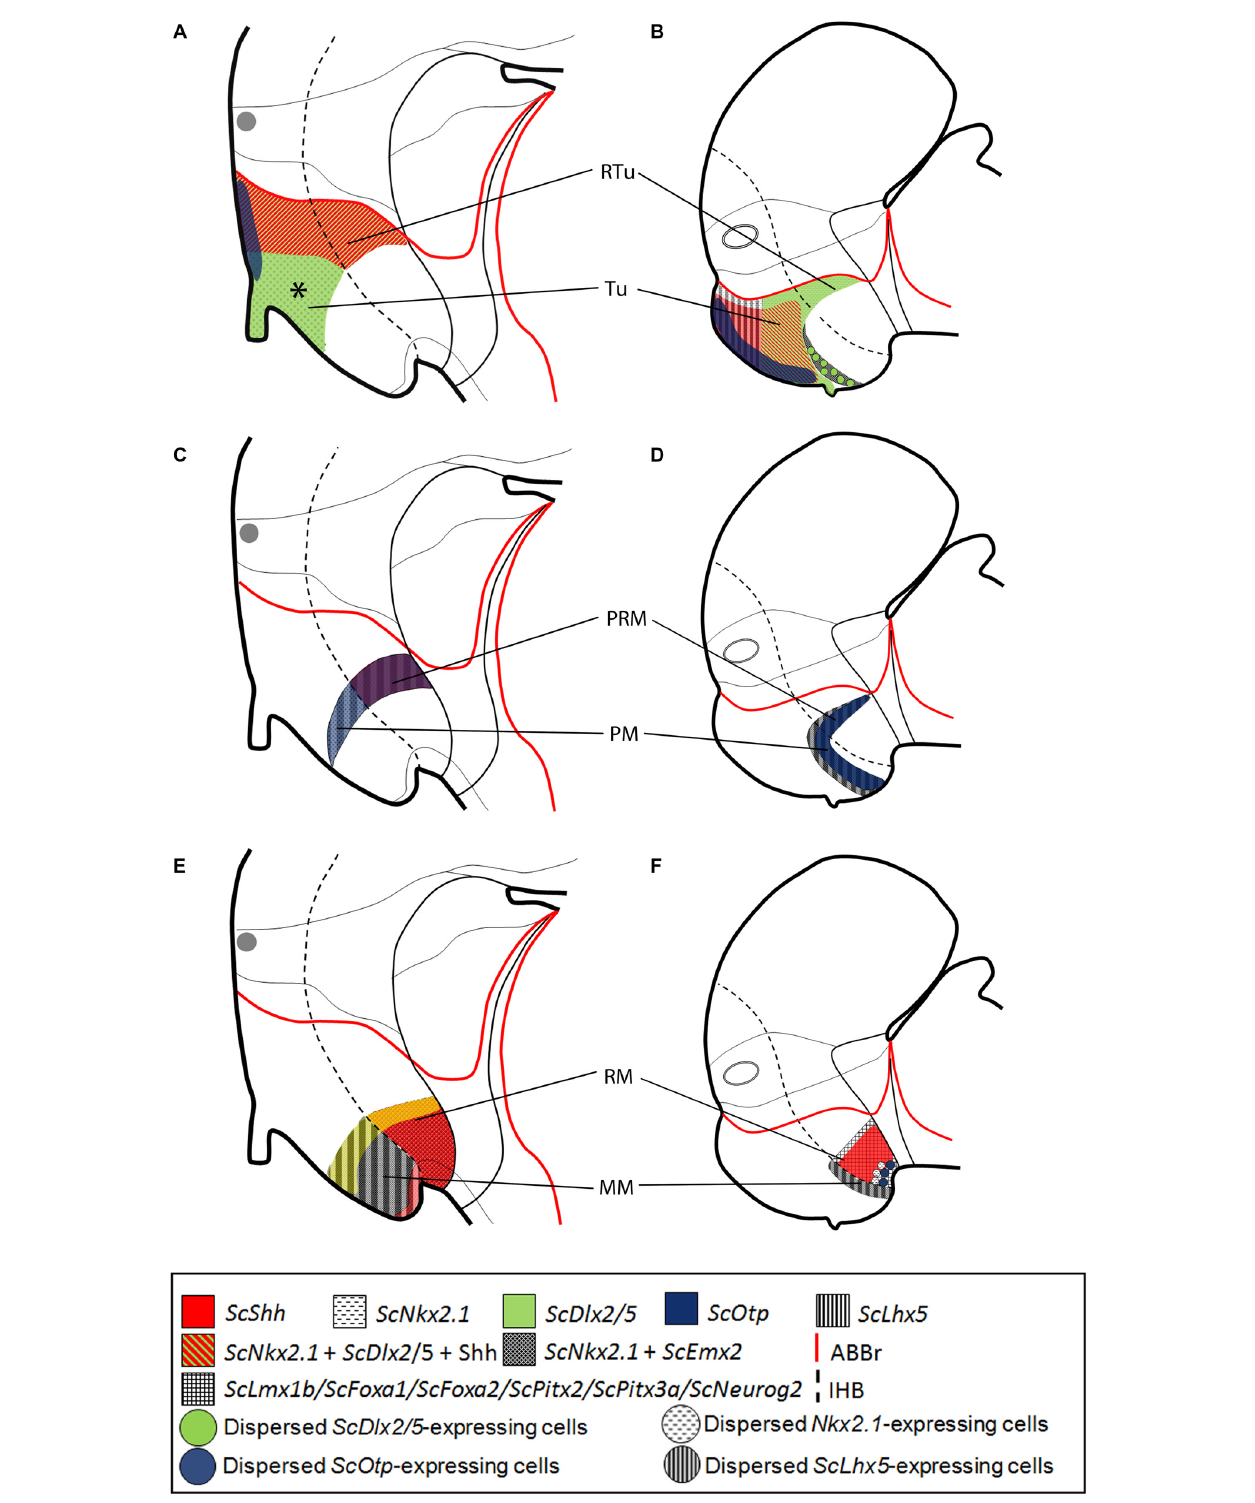
FIGURE 7 | Comparative representations of microzones defined in mammals at E13.5 (A,C,E) and chondrichthyans at stage 29 (B,D,F) by sets of ortholog genes. Comparisons consider genes expressed in prosomeric histogenetic domains ( A,B , Tu/RTu; C,D , PM/PRM; E,F , MM/RM). For simplicity schemes represent